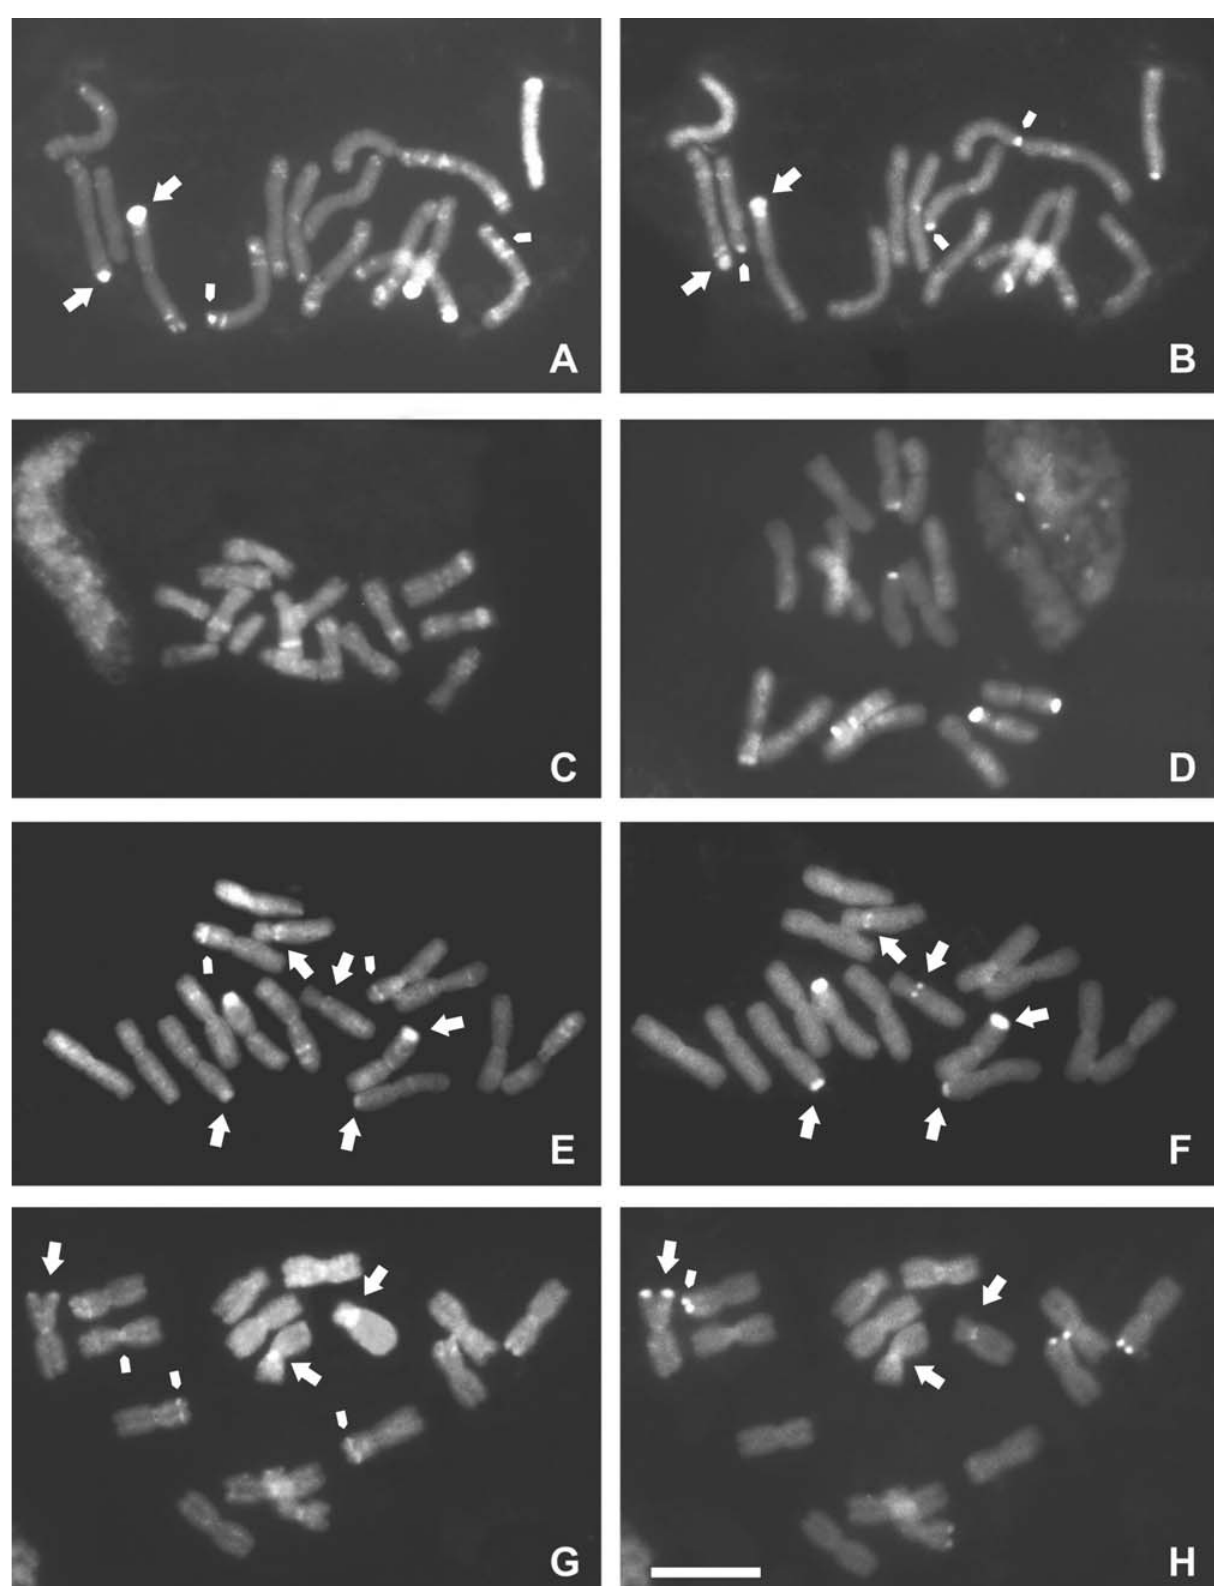
Figure 2 - Chromosome banding with fluorochromes in Cestrum species: C-DAPI banding in C. capsulare (A); C. corymbosum , incomplete metaphase (C); C. laevigatum (E); and C. megalophylum (G). C-CMA banding in C. capsulare (B), C. corymbosum (D), C. laevigatum (F) and C. megalophylum (H). The larger arrows indicate C- CMA + /DAPI + bands; the smaller arrows indicate C-CMA - /DAPI + or C-CMA + /DAPI - bands. Bar = 10 (cid:2)